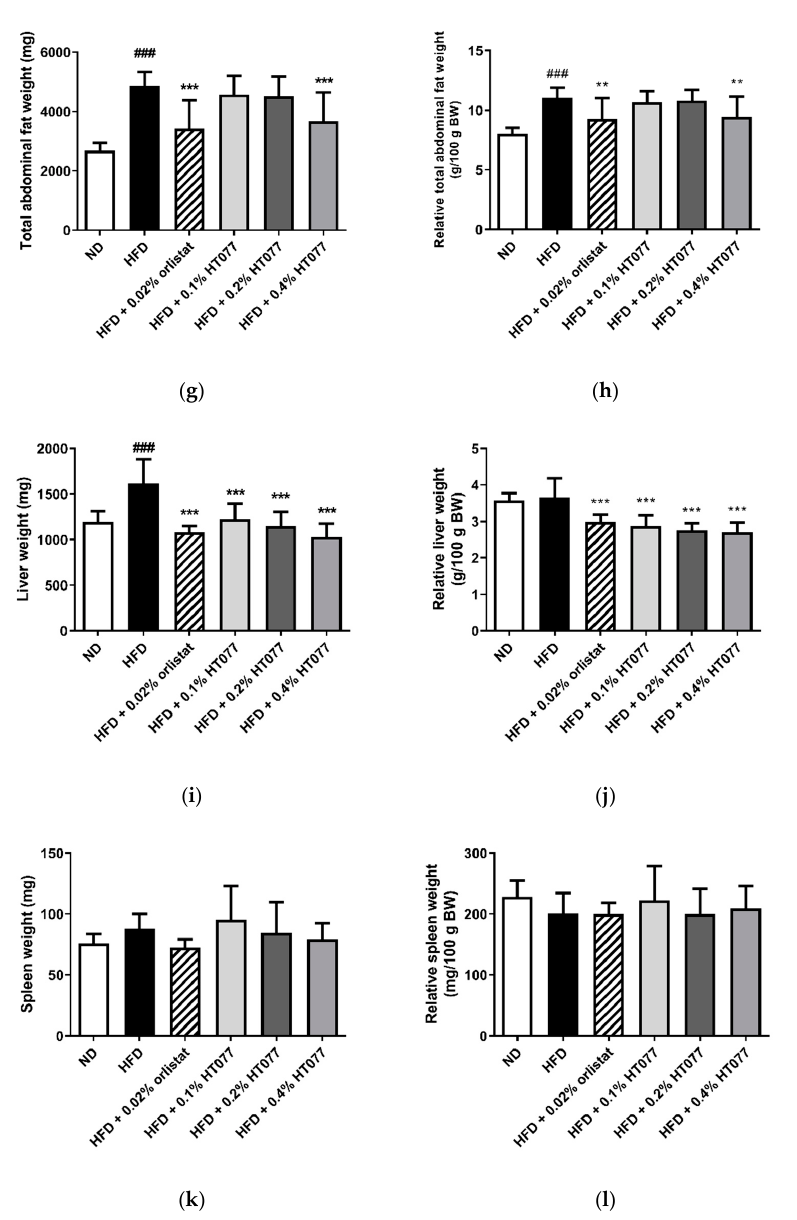
Figure 2. Effects of an extract mixture of Prunus persica and Nelumbo nucifera (HT077) on the absolute and relative weights of abdominal fat ( a–h ), liver ( i–j ), and spleen ( k–l ) in C57BL/6 mice fed a high-fat diet (HFD). The absolute wet weights of white adipose tissues isolated from visceral regions including epididymal ( a ), perirenal ( c ), and mesenteric ( e ) deposits were measured. Total abdominal fat weights ( g ) are the sums of three individual fat depots ( a , c , e ). The relative organ weight was calculated with respect to fasted body weight. Mice received either a normal diet (ND), HFD, HFD containing 0.02% orlistat, or HFD containing 0.1, 0.2, or 0.4% HT077 for 12 weeks. All values are presented as the mean ± SD ( n = 8 for ND, 16 for HFD, and 12 for the other groups). ### p < 0.001 vs. ND group; * p < 0.05 and ** p < 0.01, *** p < 0.001 vs. HFD control group. BW, body weight.